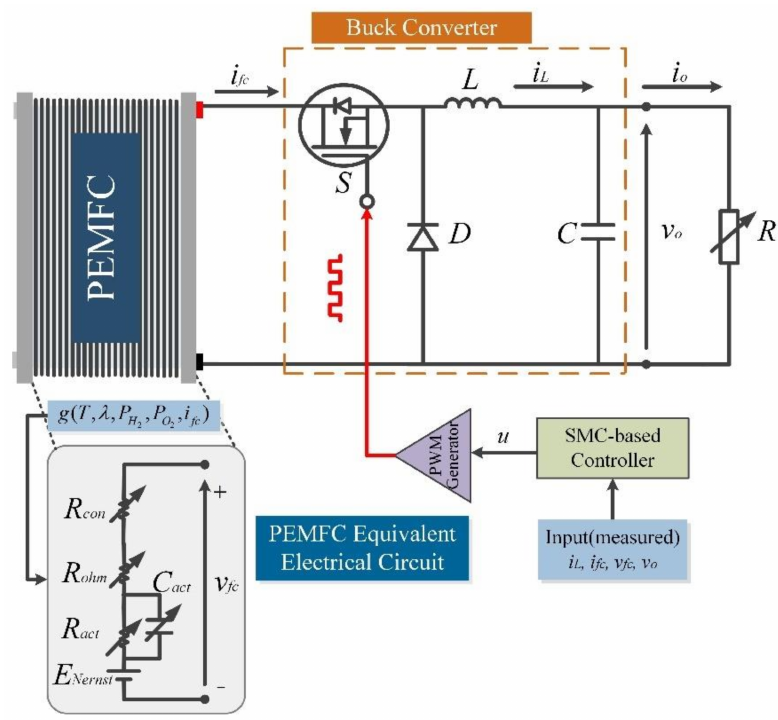
Figure 1. Circuit diagram of PEMFC power